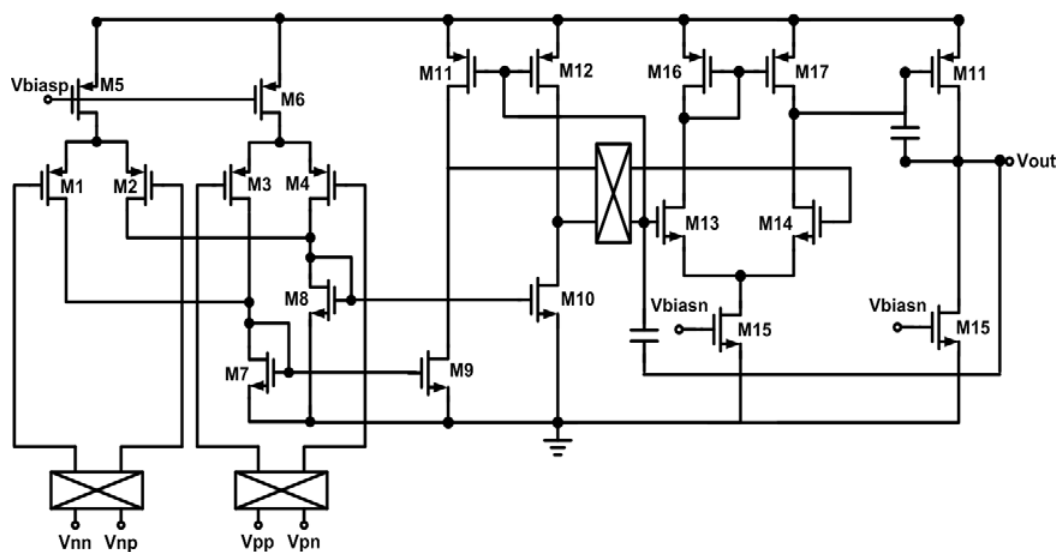
Figure 7. The chopper DDA